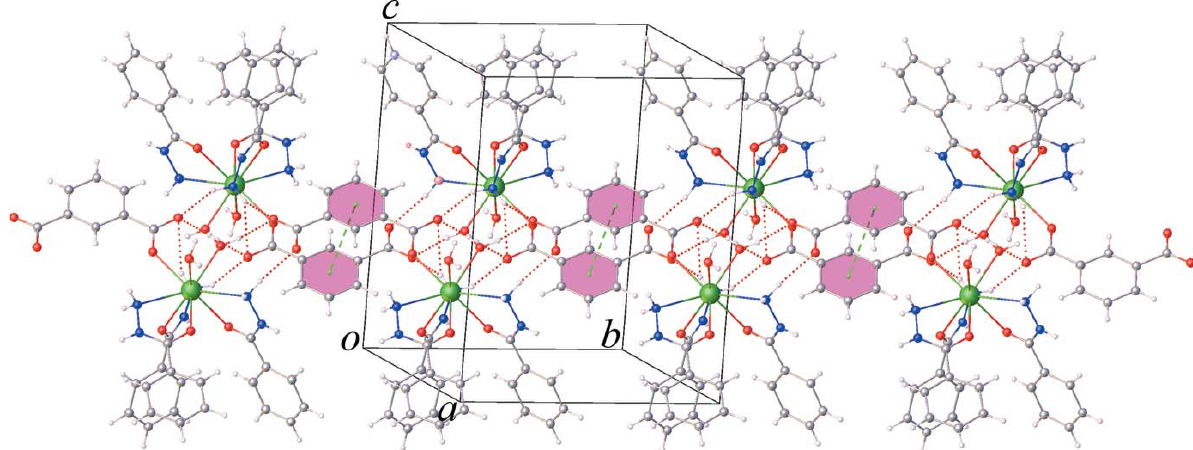
Figure 4 View of a supramolecular double chain sustained by O—H (cid:3)(cid:3)(cid:3) O and N—H (cid:3)(cid:3)(cid:3) O hydrogen bonding along with (cid:3) – (cid:3) stacking interactions.